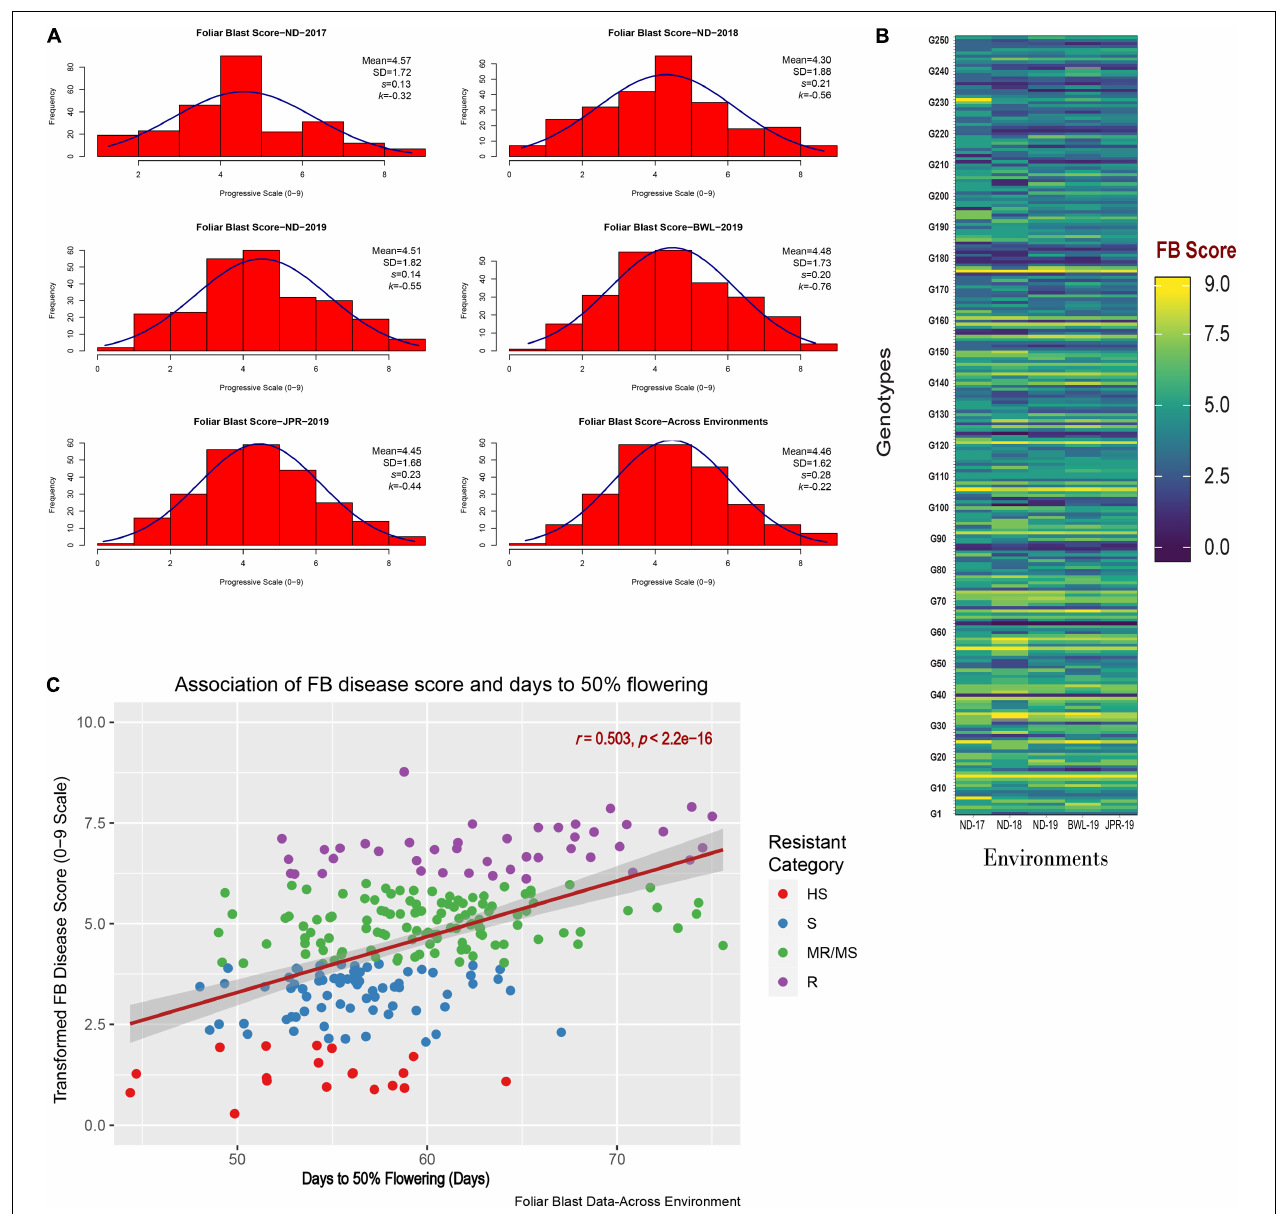
FIGURE 3 | (A) Frequency distribution for foliar blast (FB) scores in five different environments along with overall distribution indicating FB scores across the environment. (B) Heatmap visualization of genotypic FB scores observed in individual environments. Environments are depicted in the x-axis, whereas the genotypes are depicted in the y-axis containing the corresponding mean FB score recorded. (C) Scatter plot representing the association of FB disease scores (0–9 scale) with corresponding days to 50% flowering (in days) of 250 genotypes observed across environments. Days to 50% flowering of genotypes are depicted in the x-axis, whereas the transformed FB scores of genotypes are depicted by the y-axis. The regression line (with 95% confidence level) is indicated by brick red lines with gray shadows. The color of the dots indicates the resistant category to which the genotypes